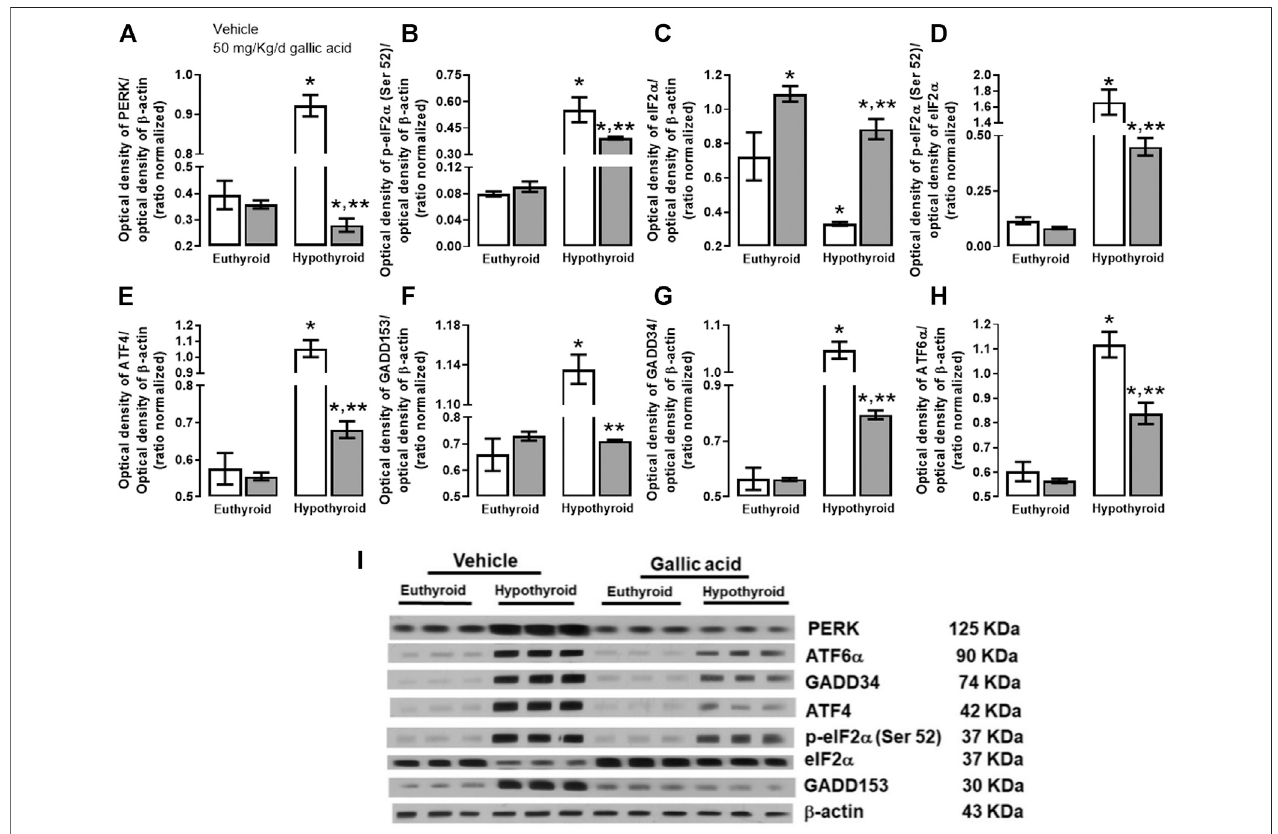
FIGURE 3 | Effect of gallic acid on hypothyroidism-induced endoplasmic reticulum stress through PERK-eIF2 α -ATF4-GADD153 pathway in the hippocampus of adult rats. The protein expresión evaluated were PERK (A) , p -eIF2 α (Ser 52) (B) , eIF2 α (C) , ATF4 (E) , GADD153 (F) , GADD34 (G) , ATF6 α (H) and the p -eIF2 α (Ser 52)/ eIF2 α ratio (D) . (I) shows the blot of the protein expression. Values represent the mean ± SEM. (*) p < 0.05 vs. Euthyroid group same treatment group. (**) p < 0.05 vs. hypothyroid + vehicle